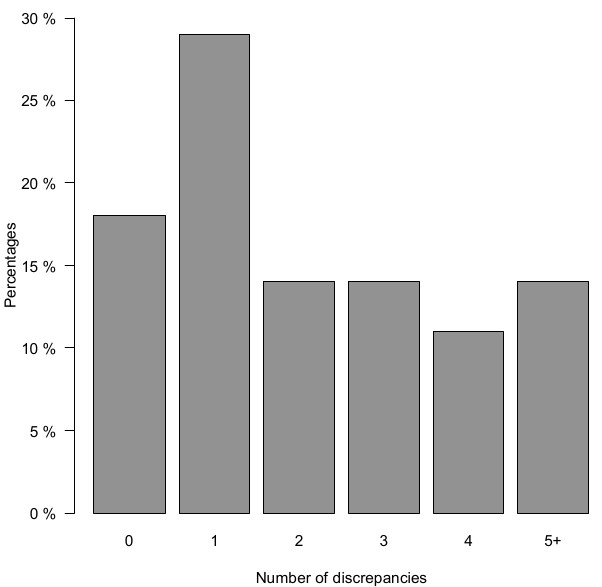
Figure 1. The percentage of patients with a specific number of discrepancies found between actual use of medication compared to the shared medication record (SMR).